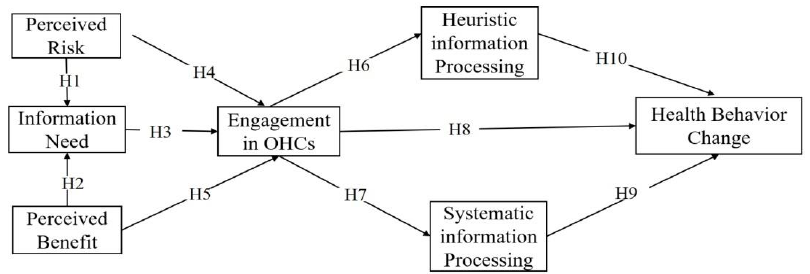
Figure 1. The conceptual research model based on PADM and HSM. H1-H10: Hypothesis 1 – 10.